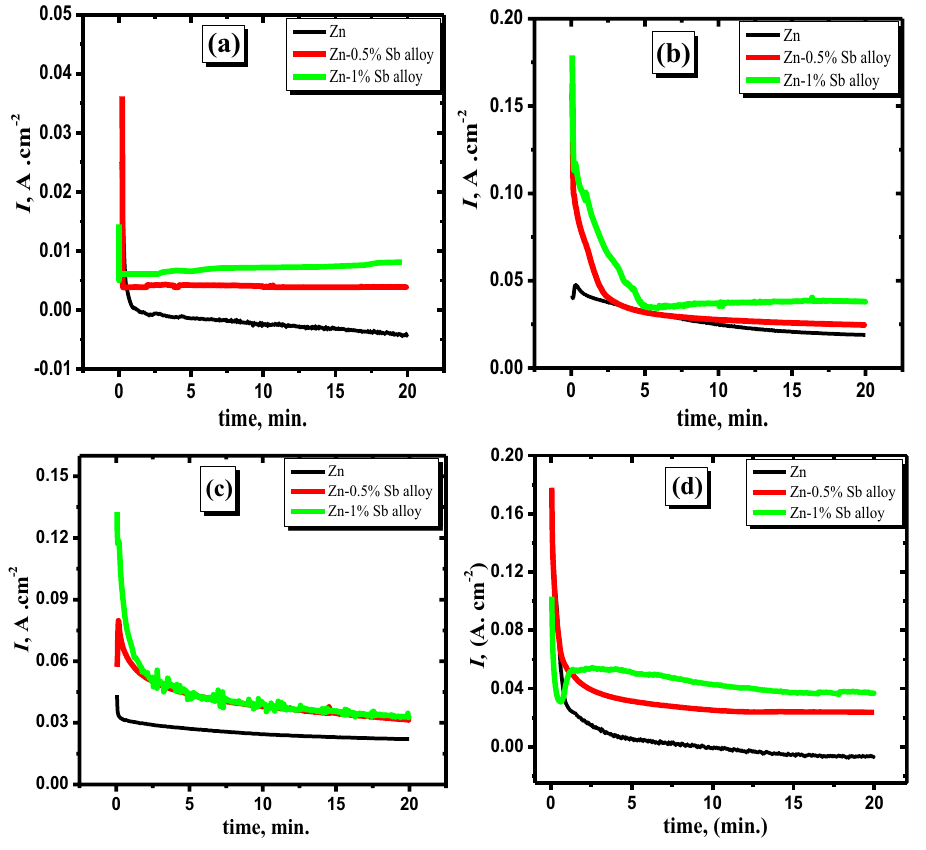
Figure 5. Current–time patterns for zinc and its alloys in 6 M KOH at potentials of − 0.6 ( a ), + 0.5 ( b ), + 0.8 ( c ), and + 1.6 V ( d ) at 25